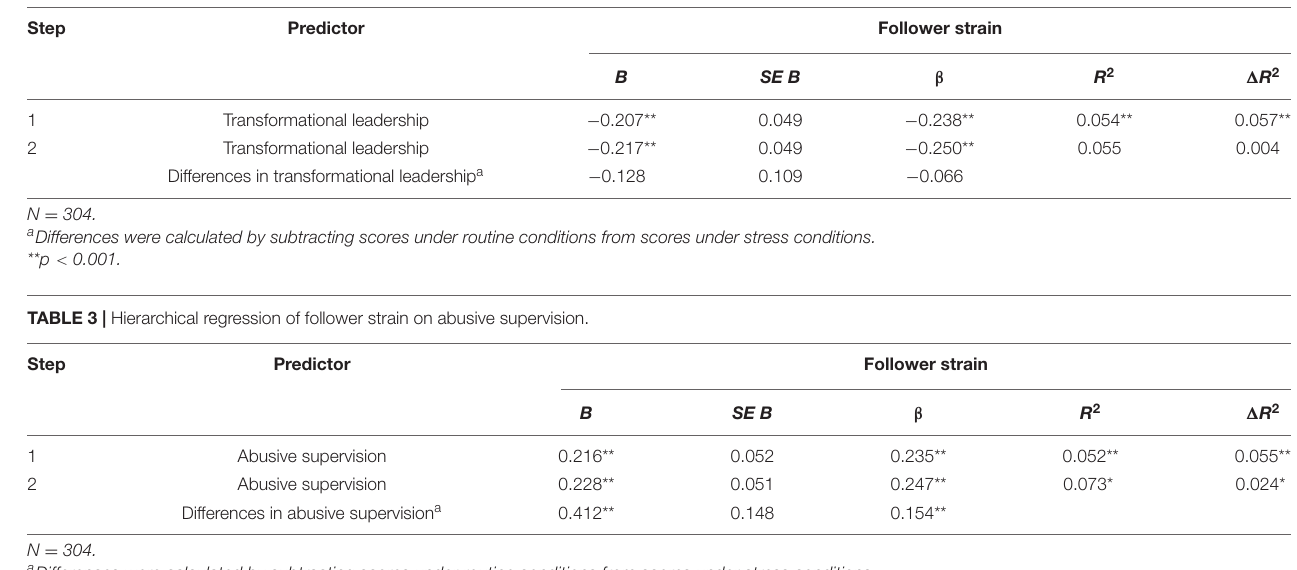
TABLE 2 | Hierarchical regression of follower strain on transformational leadership.